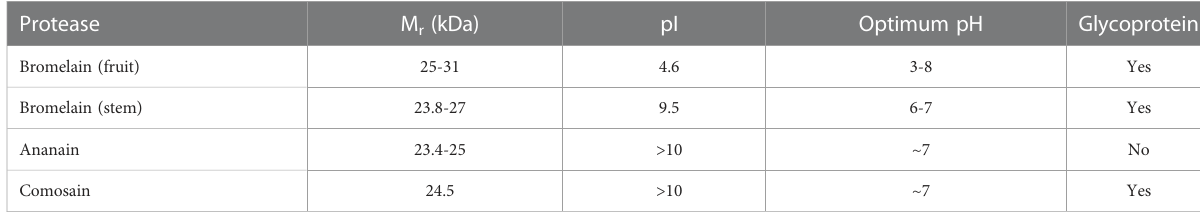
TABLE 1 summary of the most prominent characteristics of pineapple cysteine proteases (adapted from (Colletti et al., 2021; Murachi, 1976; Rowan & Buttle, 1994) (33). Protease M (kDa) pI Optimum pH Glycoprotein r Bromelain (fruit) 25-31 Bromelain (stem) Ananain Comosain 24.5